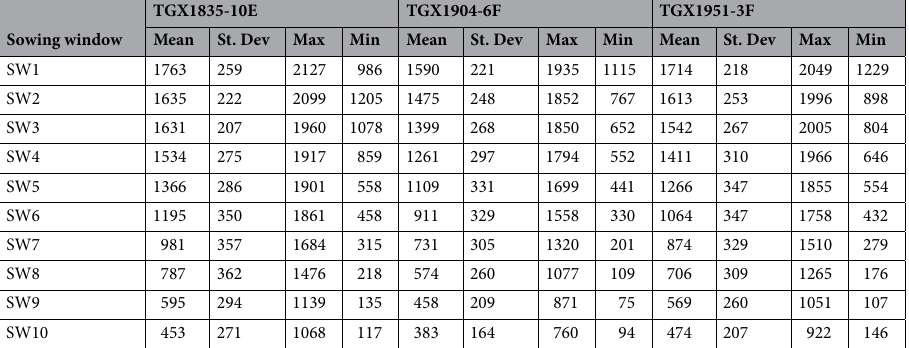
Table 5. Simulated grain yield (kg ha −1 ) of different sowing windows based on 30 ‐ year (1985–2014) seasonal analysis for soybean varieties (TGX1835 ‐ 10E, TGX1904-6F and TGX1951 ‐ 3F) in Kano (Sudan savanna).